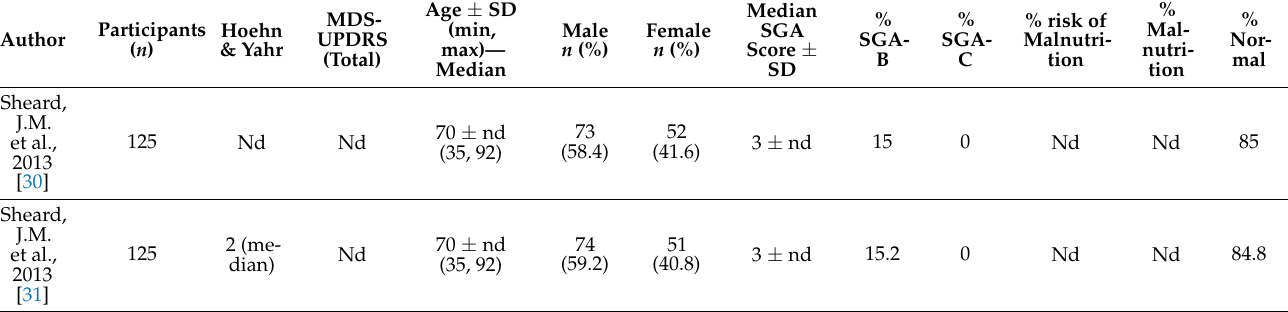
Table 5. SGA results.